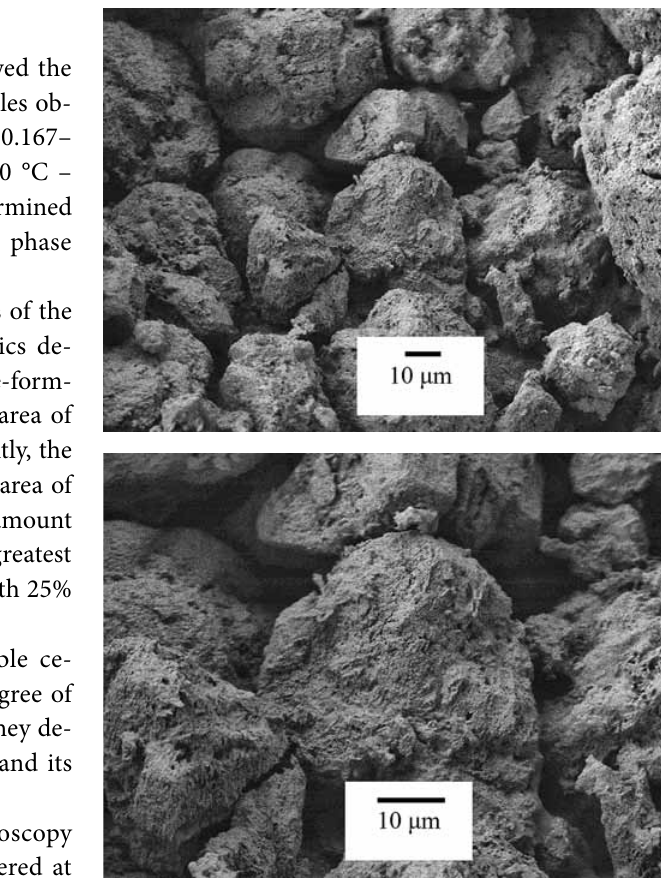
Fig. 1. SEM micrograph of the material sintered at 1350 °C